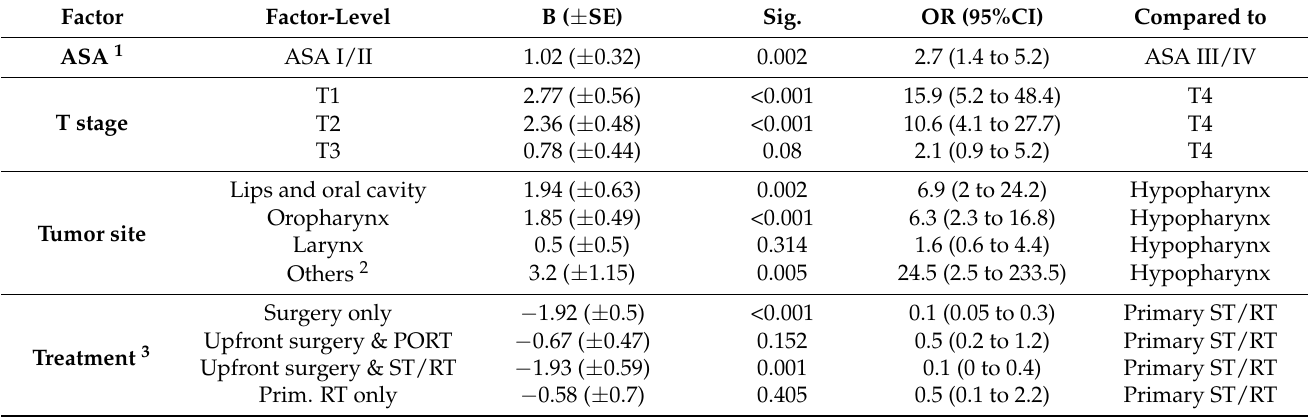
Table 5. Binary logistic model of factors influencing speech function in 416 patients with newly diagnosed HNC. Dependent variable was normal or near-normal speech function (integrity score 3 and 4) vs. impaired speech (integrity score 0–2). Factors with p values < 0.2 in Chi-square tests were included. Odds ratios (OR) indicate the chance to achieve normal or near normal speech function (the higher, the